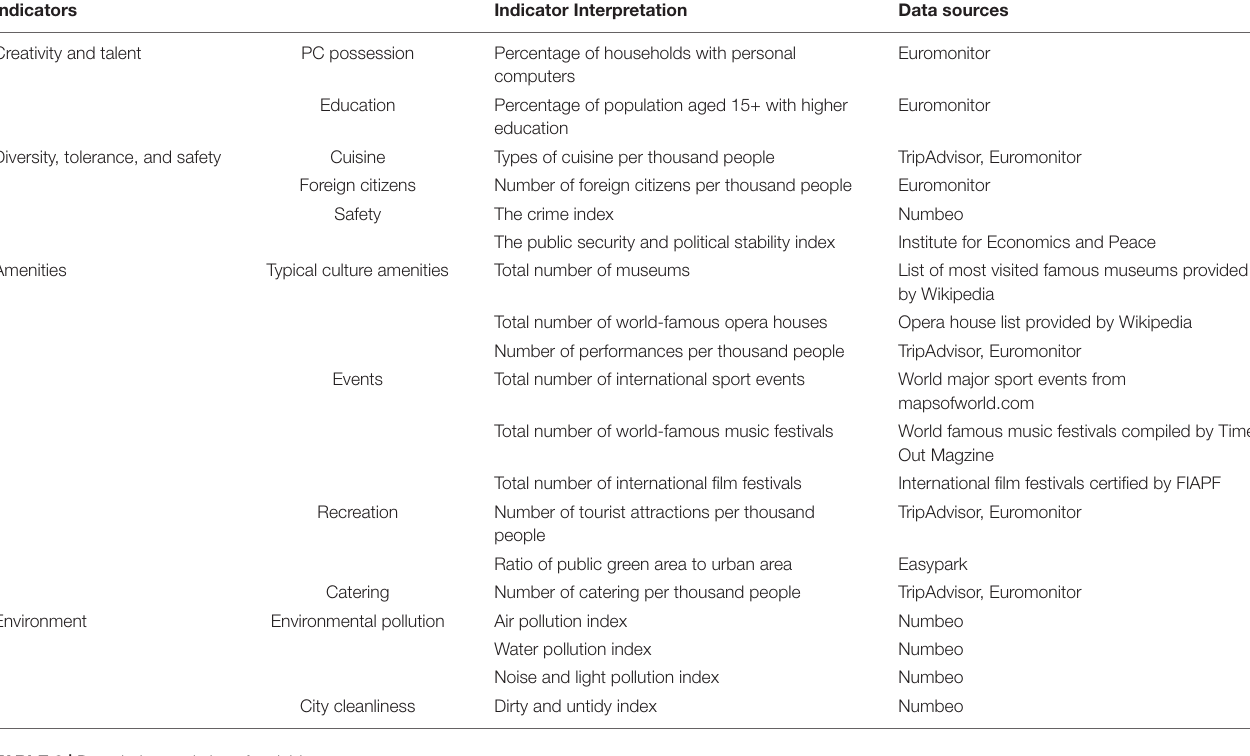
TABLE 1 | The indicator system and data sources.